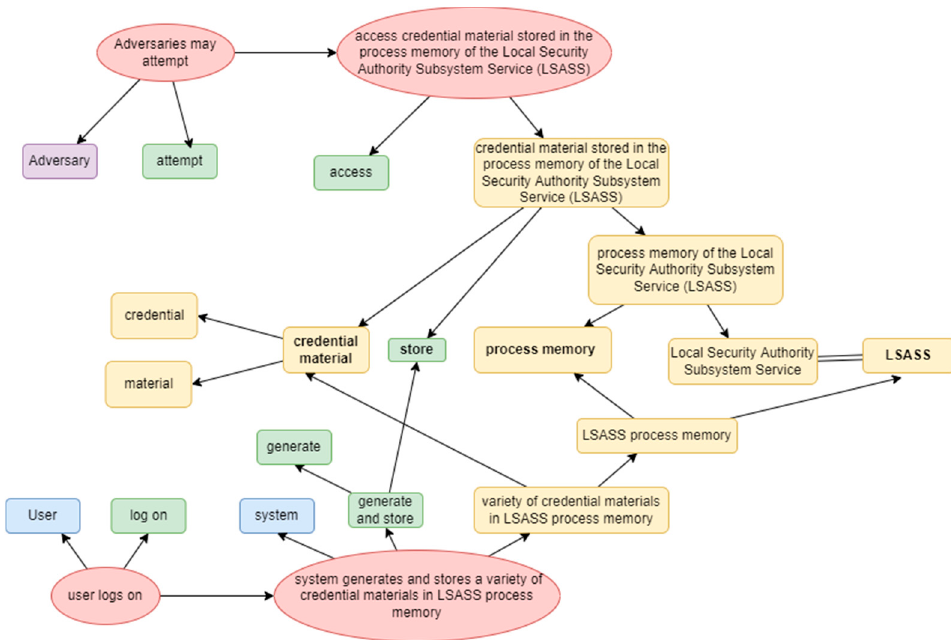
Figure 6. An example of attack technique description formalization, by indicating matching concepts between two sentences and the attack relation to system behavior.